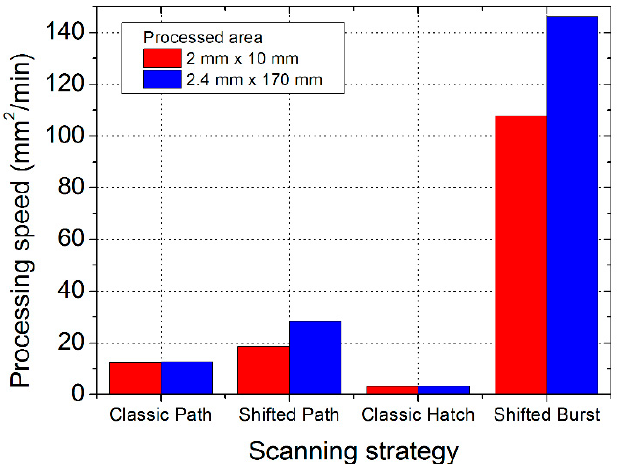
Figure 10. Processing speed obtained for di ff erent laser texturing methods (scanning strategies) at their highest allowed scanning speeds. The data are based on the measured processing times for two di ff erent processed areas.